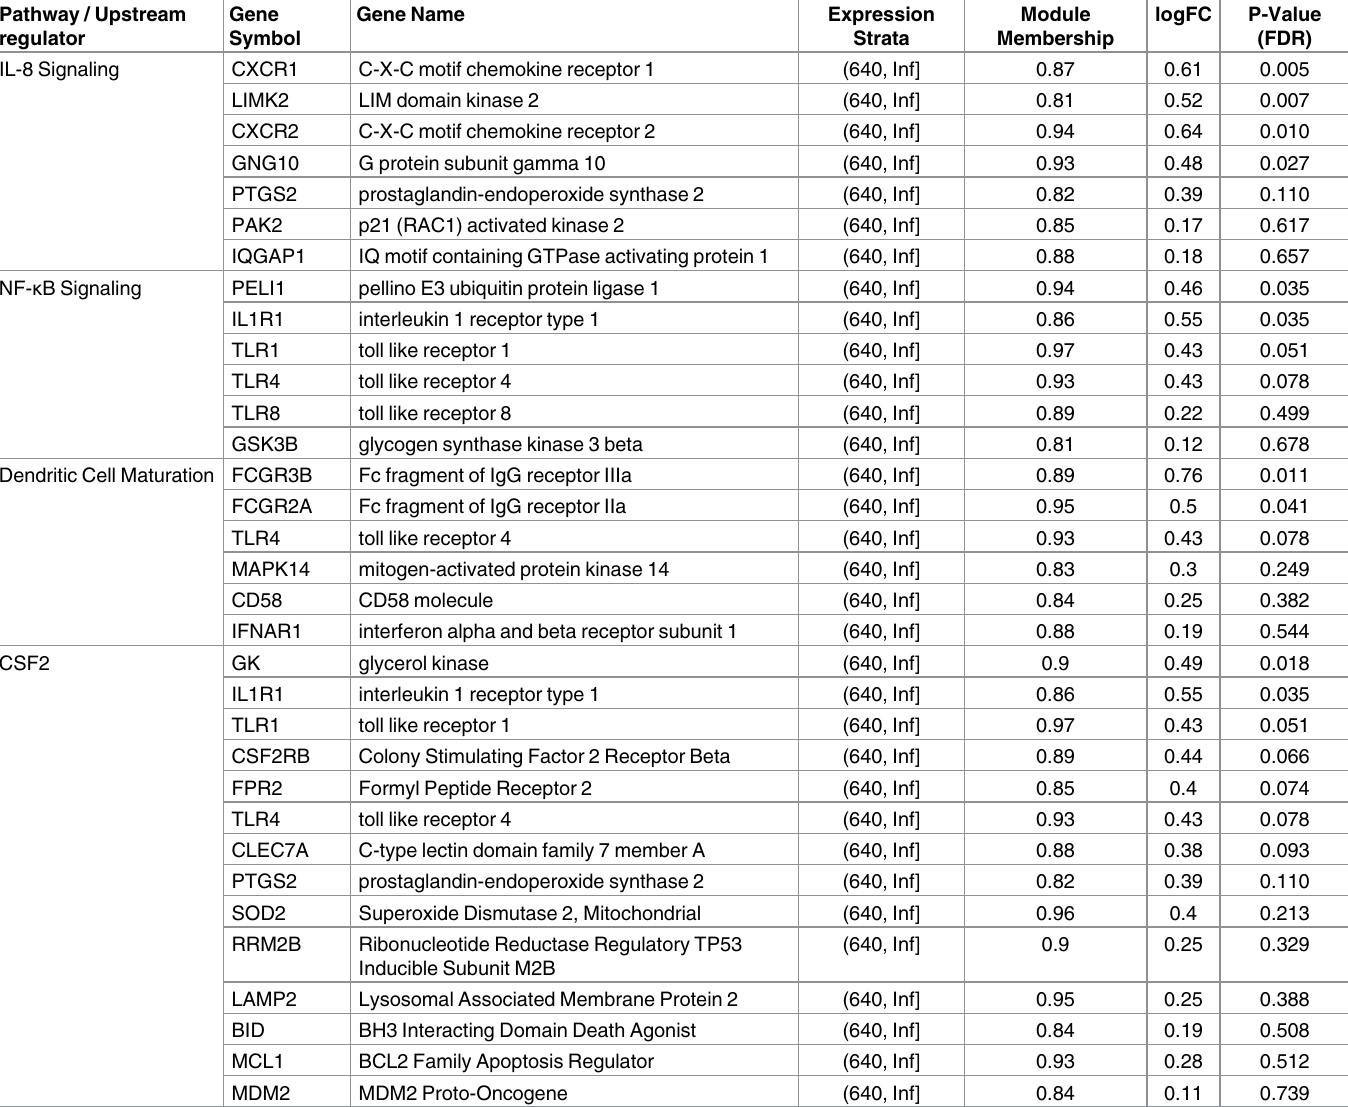
Table 3. Genes significantly differentially expressedin the steelblue by pathways and upstream regulators identified in the network module. Pathway / Upstream